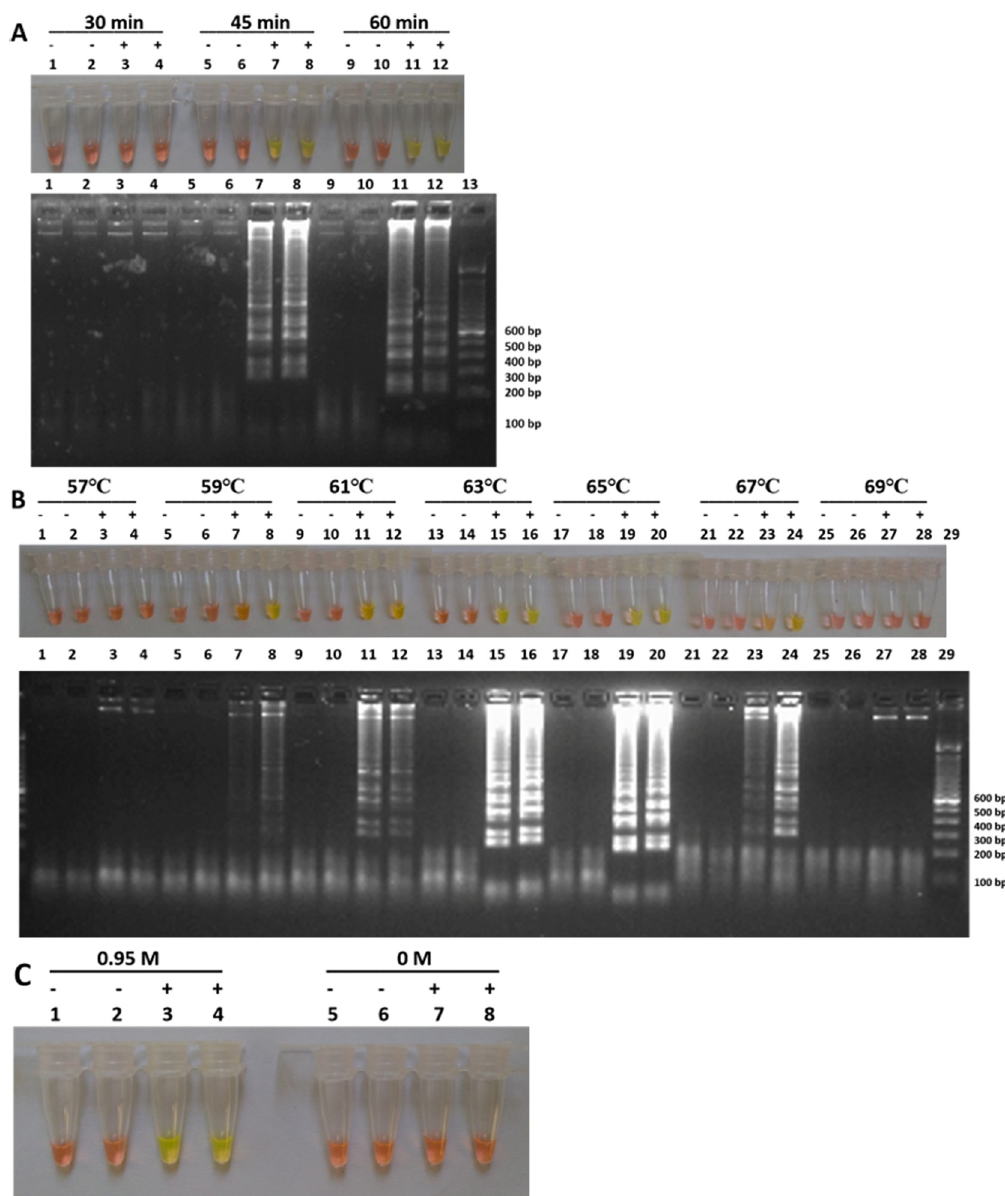
Fig 2. Optimization of LAMP caf1 . Optimal reaction was found by varying LAMP reaction parameters. Amplification was verified by naked eye with color change from orange to green (positive test) and without color change remaining orange (negative test) and by agarose gel electrophoresis. Optimization results of (A) the reaction time: 30 min (Tubes and Lanes 1–4), 45 min (Tubes and Lanes 5–8) and 60 min (Tubes and Lanes 9–12) (B) the reaction temperature: 57˚C (Tubes and Lanes 1–4), 59˚C (Tubes and Lanes 5–8), 61˚C (Tubes and Lanes 9–12), 63˚C (Tubes and Lanes 13–16), 65˚C (Tubes and Lanes 17– 20), 67˚C (Tubes and Lanes 21–24) and 69˚C (Tubes and Lanes 25–28) (C) the betaine concentration: 0 M (Tubes 1–4) and 0.95 M (Tubes